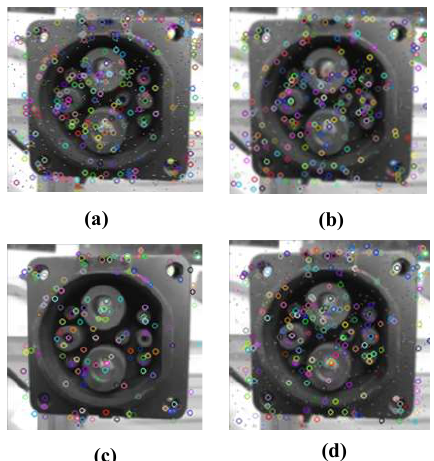
b Figure 5. Checkerboard before and after stereo correction processing: ( a ) Before stereo correction; ( b ) After stereo correction. 5.2. Experiments on Image Retrieving and Key Point Extraction 5.2.1. Image Preprocessing The charging pile is generally set outdoors with a strong magnetic and electric scene, in which environment the image obtained by the camera will inevitably contain noise. Therefore, image filtering preprocessing is required to suppress the noise of the image while retaining the as many details of the image as possible to ensure the smooth extrac-